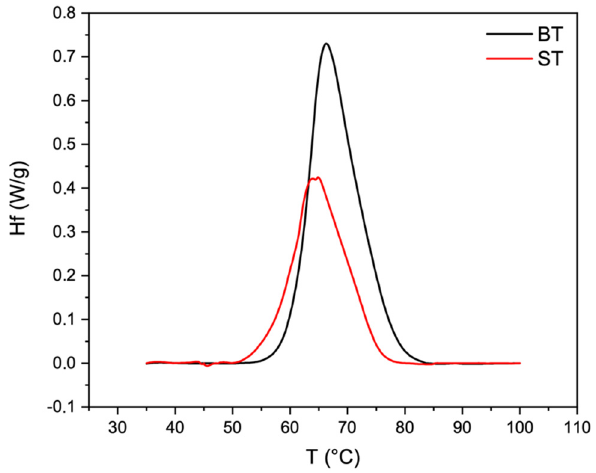
Figure 1. Representative DSC thermograms of ST and BT.